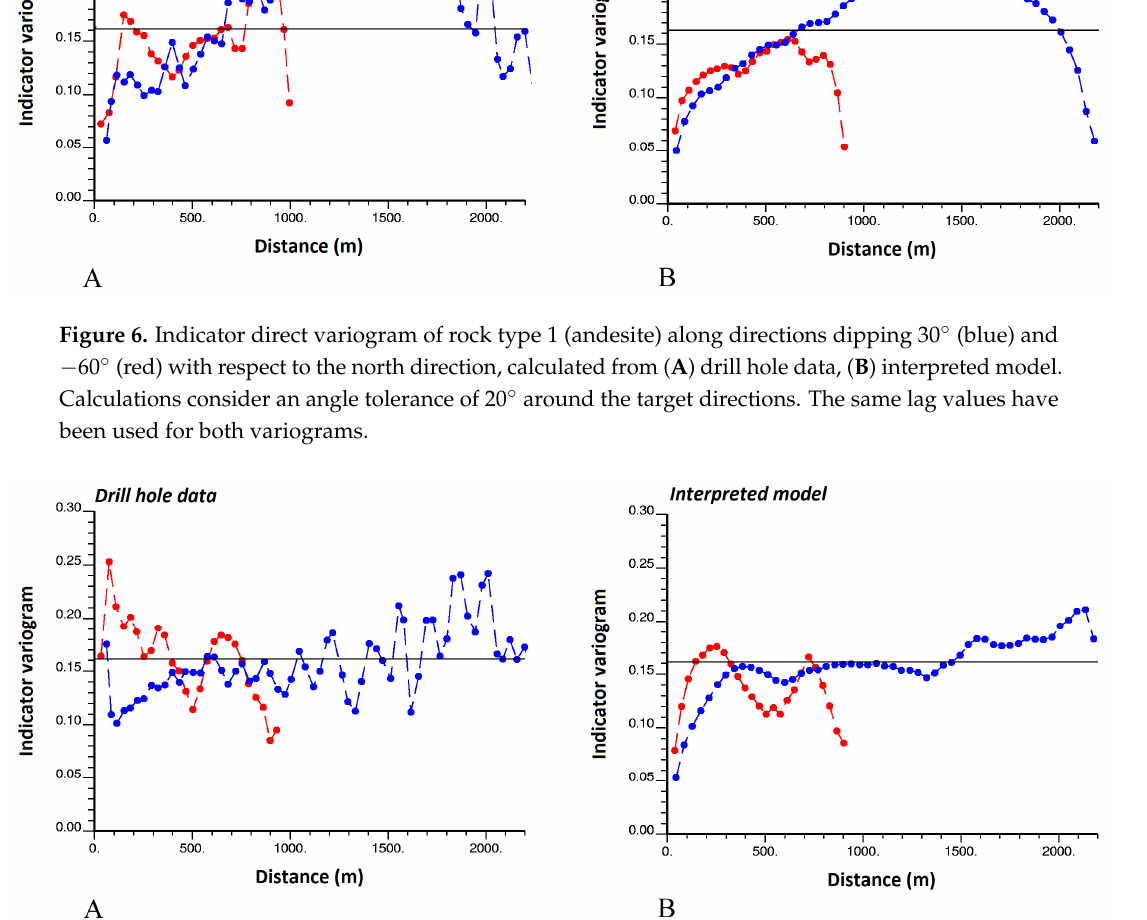
Figure 7. Indicator direct variogram of rock type 3 (sedimentary rocks) along directions dipping 30° (blue) and − 60° (red) with respect to the north direction, calculated from ( A ) drill hole data, ( B ) interpreted model. Calculations consider an angle tolerance of 20° around the target directions. The same lag values have been used for both variograms.